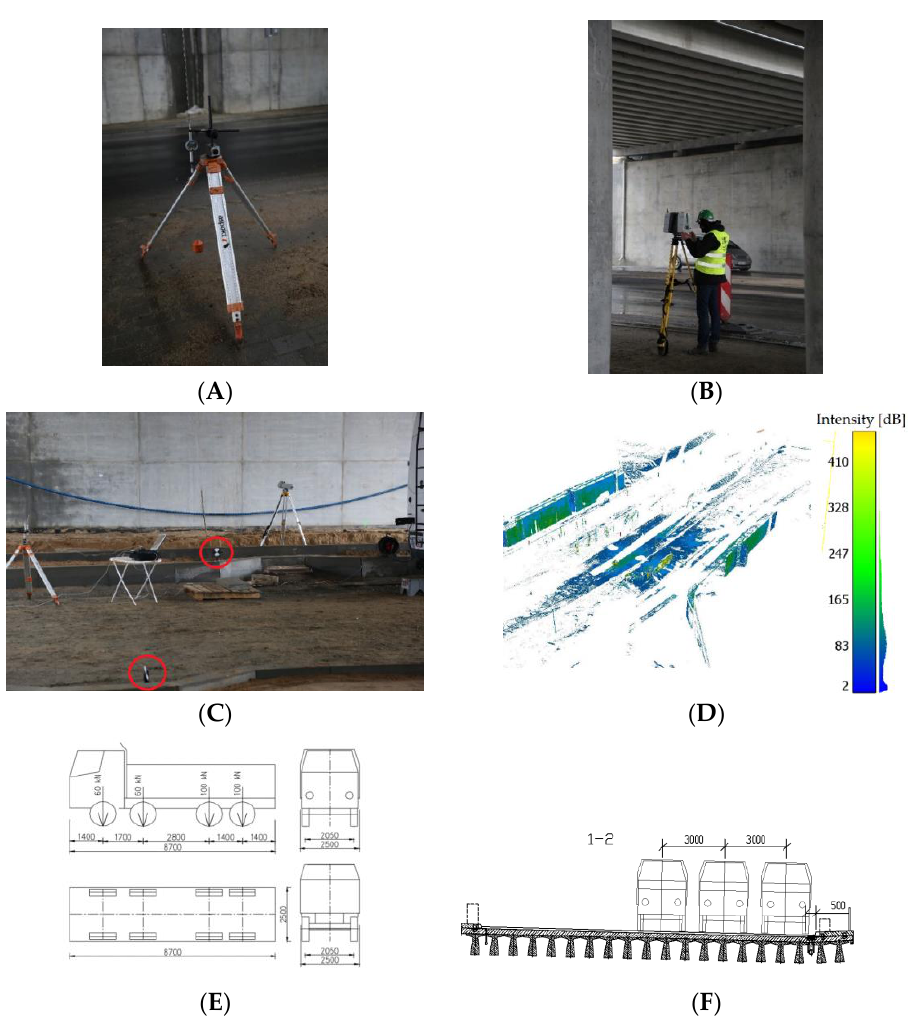
Figure 10. ( A ) Measuring sensor for measuring linear displacements; ( B ) a laser scanner when working with the operator; ( C ) TLS targets; ( D ) a separated point cloud applied to align data between scan positions; ( E ) pressure, wheel tracks, and dimensions of trucks loaded up to the calculation version; ( F ) view of the actual setting.